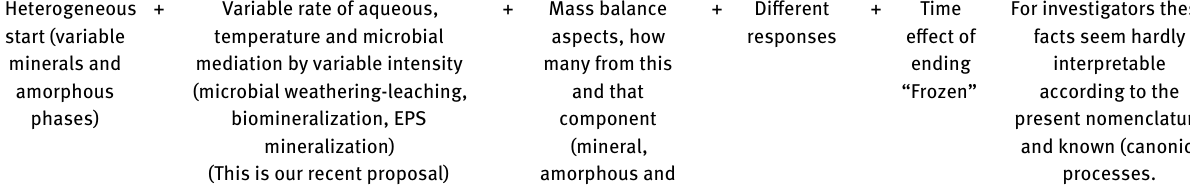
Table 4. Simplified order of processes and important influencing factors.